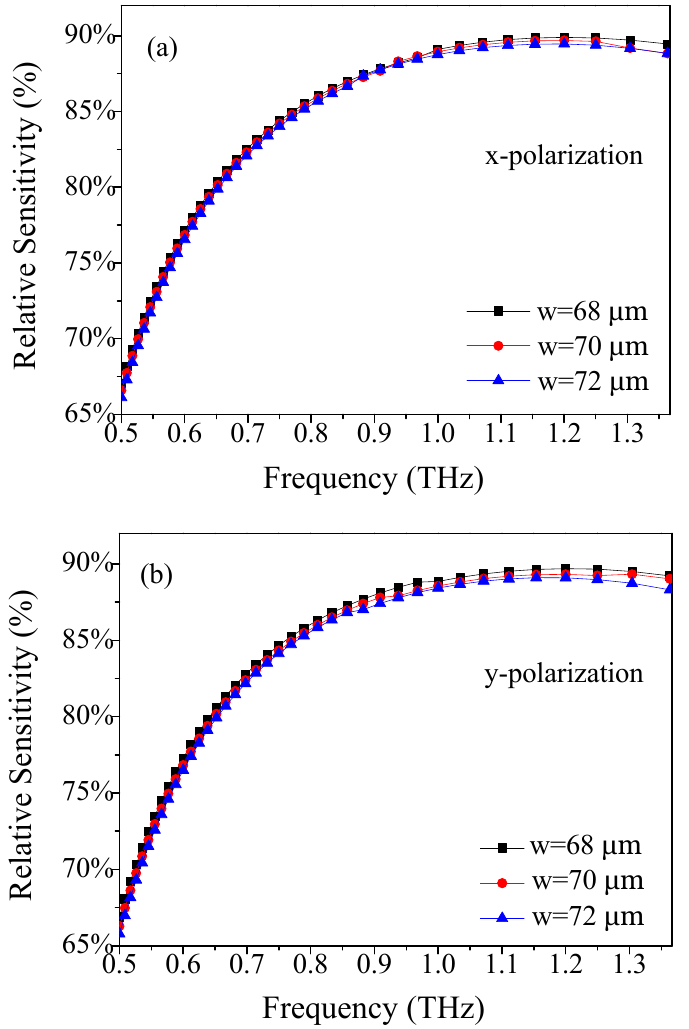
Figure 4. Frequency dependence of the relative sensitivity of ( a ) x- and ( b ) y-polarization for the width of rectangular porous core (w).